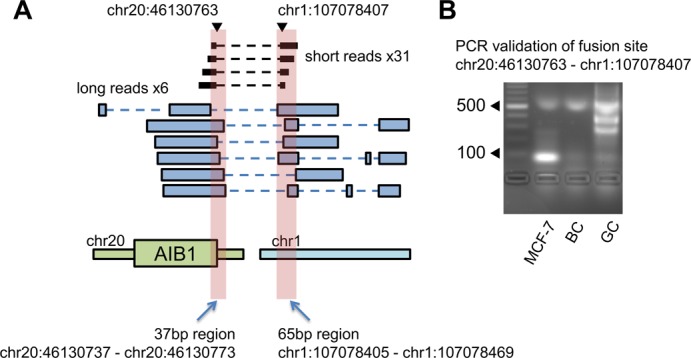
Precise fusion site determination of the fusion gene AIB1–chr1:107078407. (A) A fusion between AIB1 and an unannotated region of chromosome 1 was detected by six long reads (blue blocks), but the long read alignment ends are not in agreement on the precise fusion site. The alignment ends of the long read fragments span 37 and 65 bp at two sides, respectively. IDP-fusion aligned 31 short reads (black blocks) to the fusion site precisely at chr20:46130763–chr1:107078407. In particular, chr20:46130763 is the 3′ end of the first exon of AIB1 and the canonical splicing signal is found in this fusion site. (B) The fusion site chr20:46130763–chr1:107078407 was PCR validated from MCF-7 cDNA, but not healthy breast cDNA (BC) or a genomic control (GC).